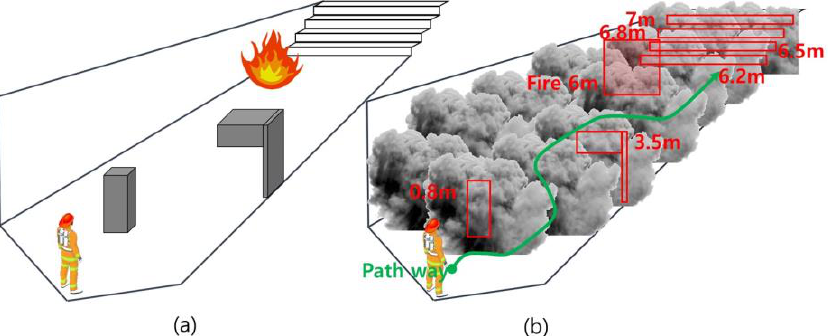
Figure 1. Motivation: Provide visual information to firefighters: ( a ) normal environment (every- thing can be seen), ( b ) object detection through sensor fusion to visualize objects in a dense smoke environment (nothing can be seen) .